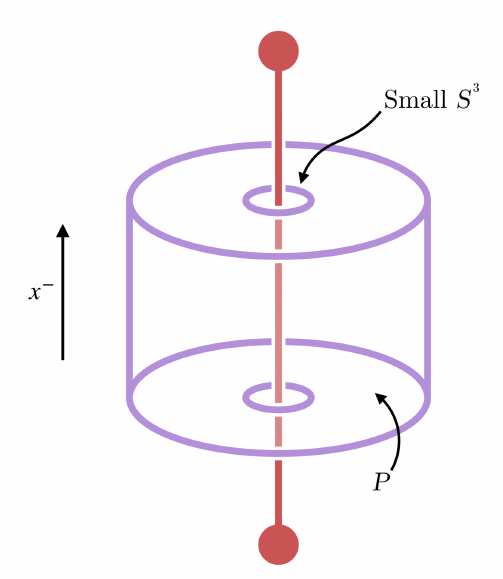
Figure 1 . Pillbox integral with vanishing Q .